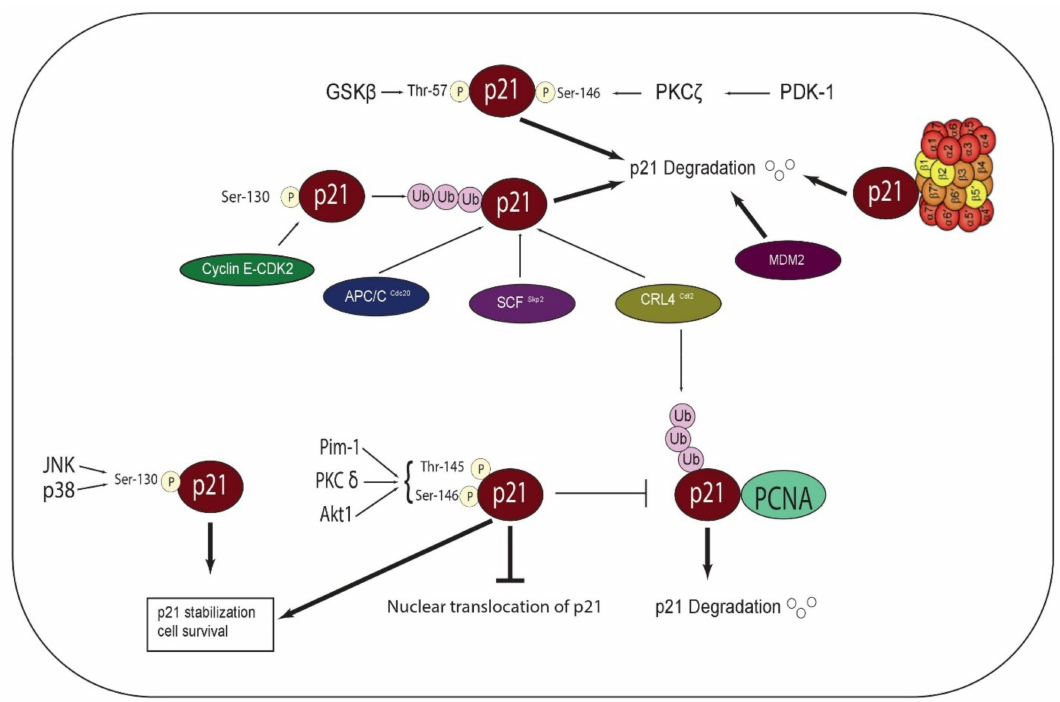
Figure 2. Post-transcriptional regulation of p21. Pim-1, PKC, and Akt1 kinases phosphorylate Thr-145 and Ser-146 sites on p21 protein. Phosphorylation at Thr-145 promotes cytoplasmic translocation and stability of p21. Ser-146 phosphorylation mediated by Akt1 enhances p21 stabilization and promotes cell survival. Phosphorylation of p21 at either site disrupts the interaction between p21 and PCNA, thus inhibiting CRL4-mediated ubiquitination and degradation of p21. Phosphorylation at Ser-146 by PKC δ increases p21 stability, whereas phosphorylation of the same serine by PDK1-activated PKC ζ results in p21 degradation. Similarly, glycogen synthase kinase-3 (GSK β ) phosphorylates Thr-57 and induces p21 degradation. JNK and p38 phosphorylate p21 at Ser-130 and increase its stability. Cyclin E- CDK2 complex phosphorylates p21 at Ser-130, resulting in the ubiquitin-dependent degradation of p21. Cell cycle-related ligases mediate ubiquitination and degradation of p21, and include Anaphase Promoting Complex / Cyclosome and its activator Cdc20 (APC / CCdc20), SCFSkp2, and CRL4Cdt2. p21 can directly bind the C8 alpha-subunit of the 20S proteasome, mediating proteasome assembly and ubiquitylation-independent degradation of p21. Strikingly, MDM2 mediates the degradation of p21 independent of its ubiquitin E3 ligase